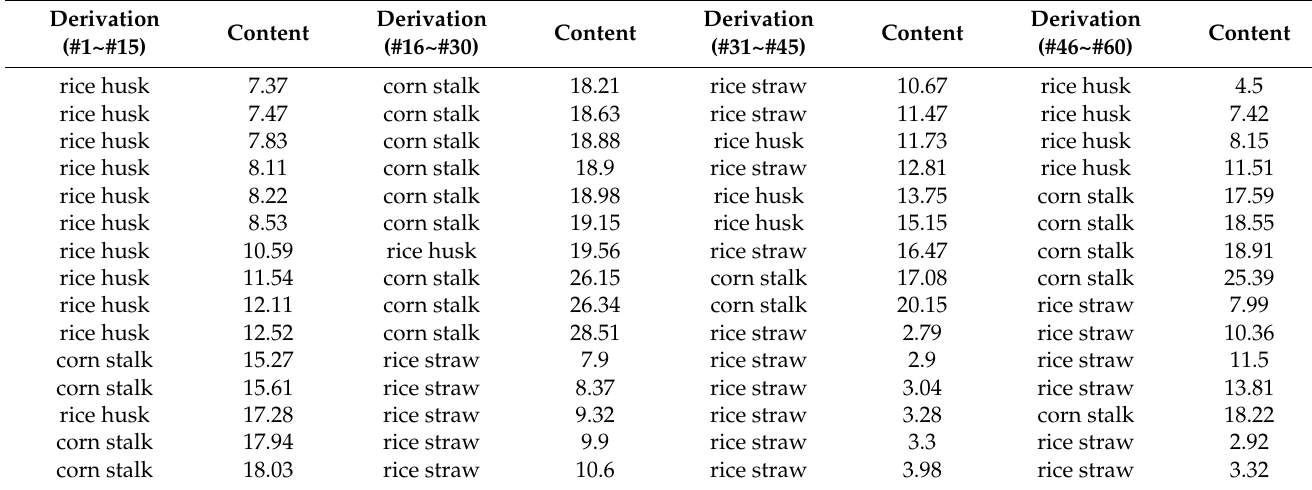
Table 4. Statistical results of Cr (mg/kg)